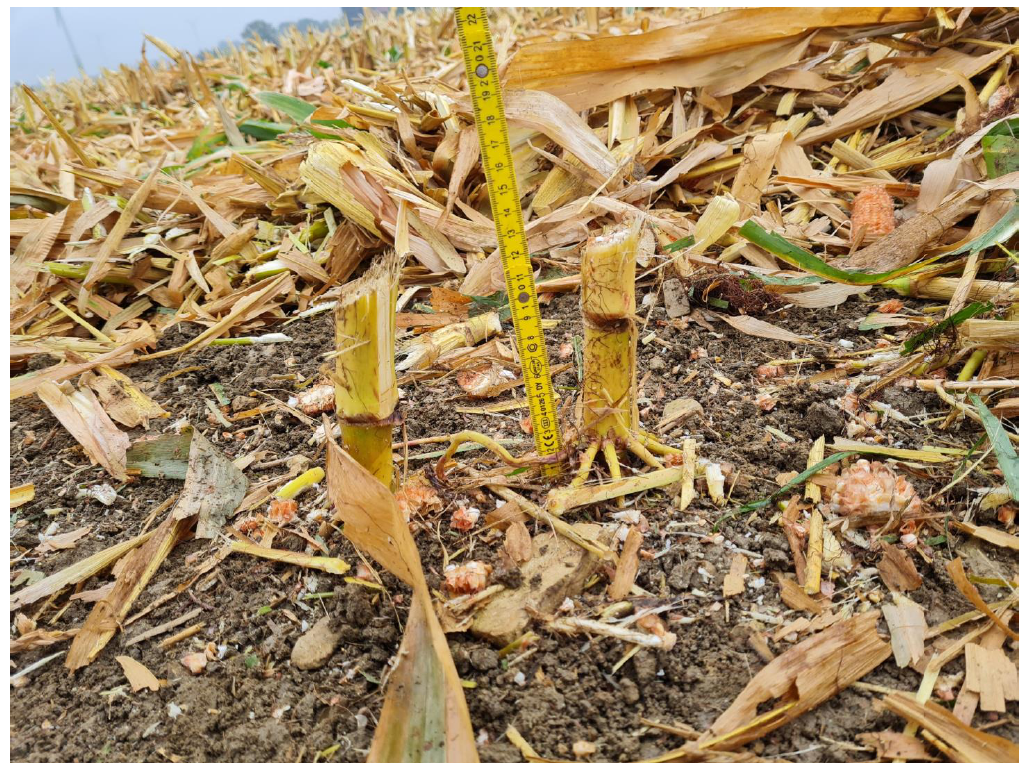
Figure A4. Corn stubble processed by the corn header equipped with standard knives (cutting height level 1).